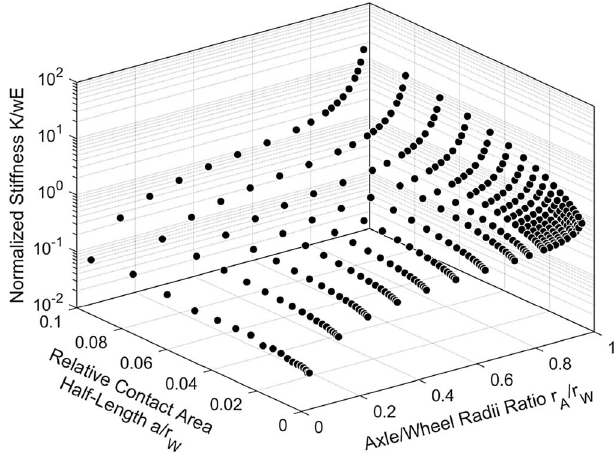
Figure 7. Normalized wheel stiffness as a function of axle/ wheel radii ratio and relative contact area half-length. Plotted on a logarithmic z -scale (base